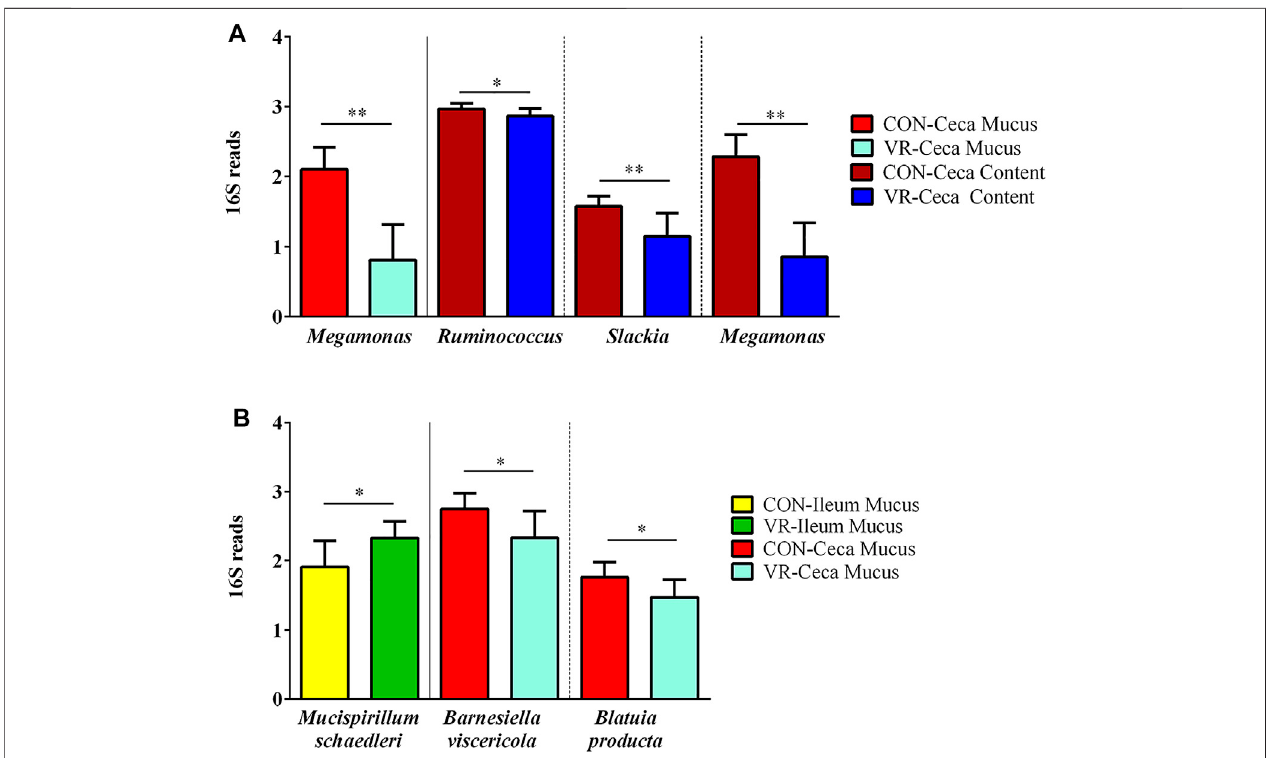
FIGURE6 | Summary ofbacterial taxonomic differences at genus (A) and species (B) levels between CON and VRbirds ( n = 15/group) via 16SrRNA sequencing. Yellow, CON ileum mucus. Green, VR ileum mucus. Bright red, CON ceca mucus. Bright blue, VR ceca mucus. Dark red, CON ceca content. Dark blue, VR ceca content. * p < 0.05; ** p <